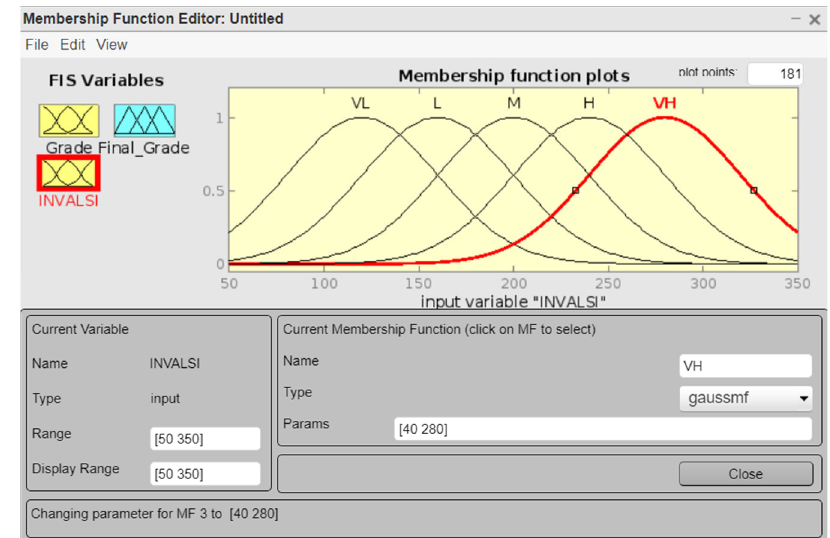
Figure 7. The “Fuzzy Logic Toolbox” in the MATLAB program.